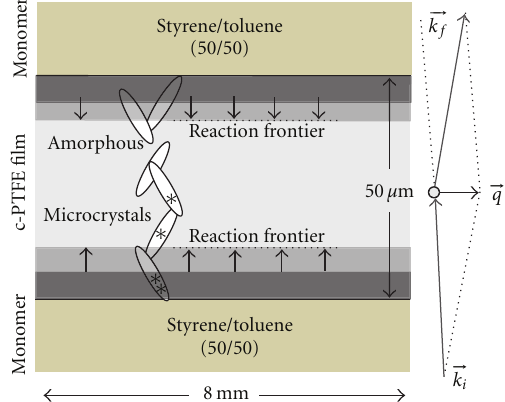
Figure 3: A schematic view showing a PTFE film during Preirradi- ation graft polymerization.